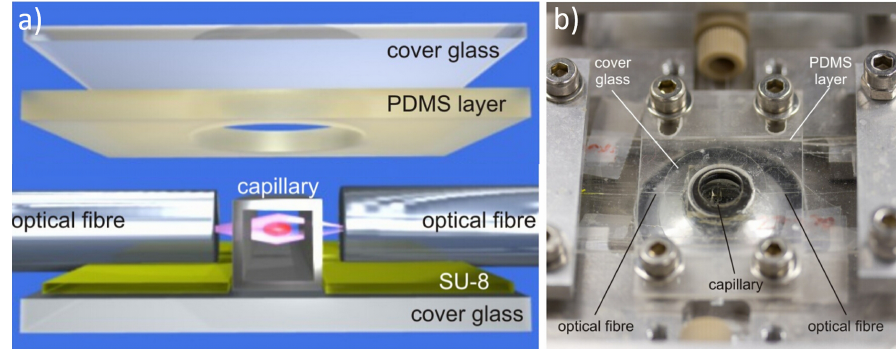
Figure 2. The structure of the discrete-element optical stretcher. ( a ) 3D rendering of the constituent components and their positions; ( b ) The finished system is mounted on a microscope plate. Figure reproduced from Reference [29] with permission from Optical Society of America.